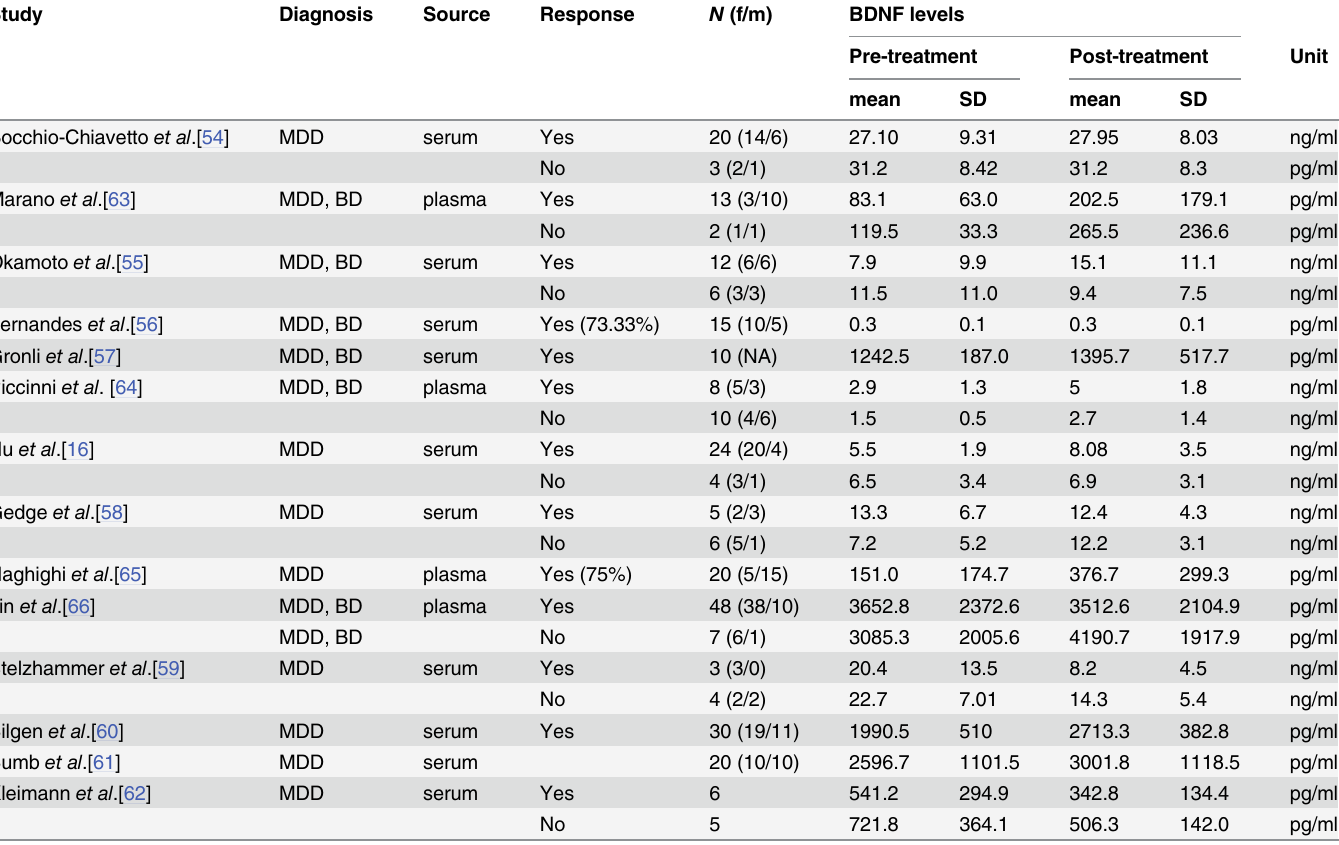
Table 4. Basic information on the clinical studies included in the